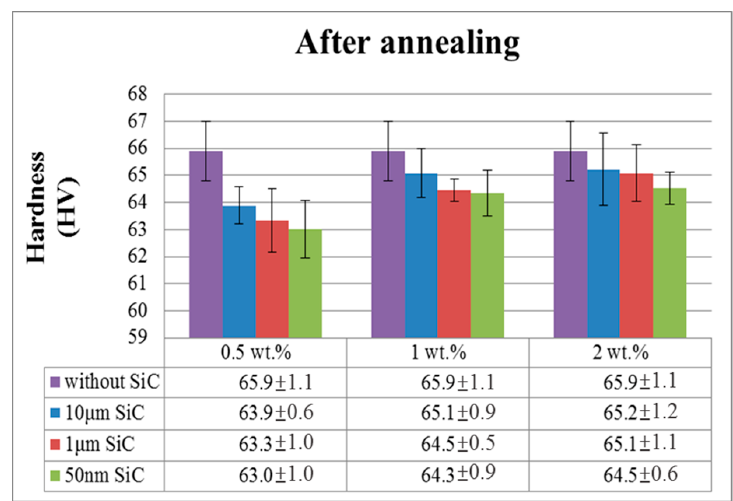
Figure 9. Hardness of the AZ61/SiCp MMC extruded plates after annealing.